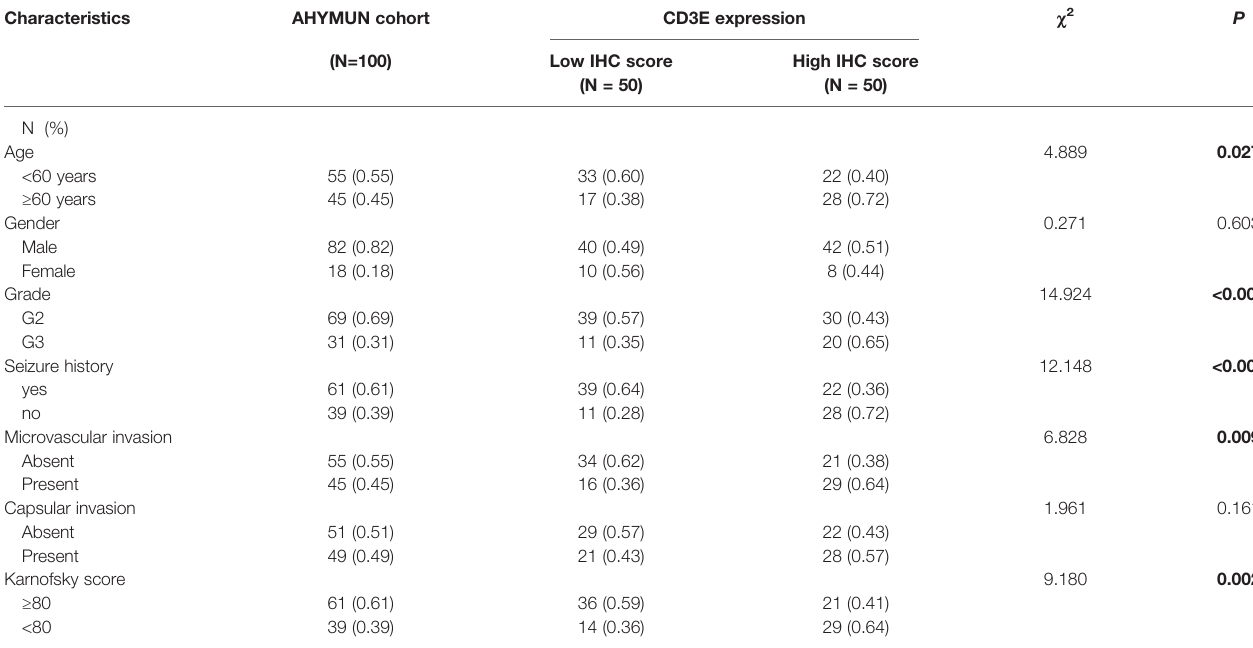
TABLE 1 | Clinicopathological characteristics in relation to CD3E expression level in AHYMUM cohort.